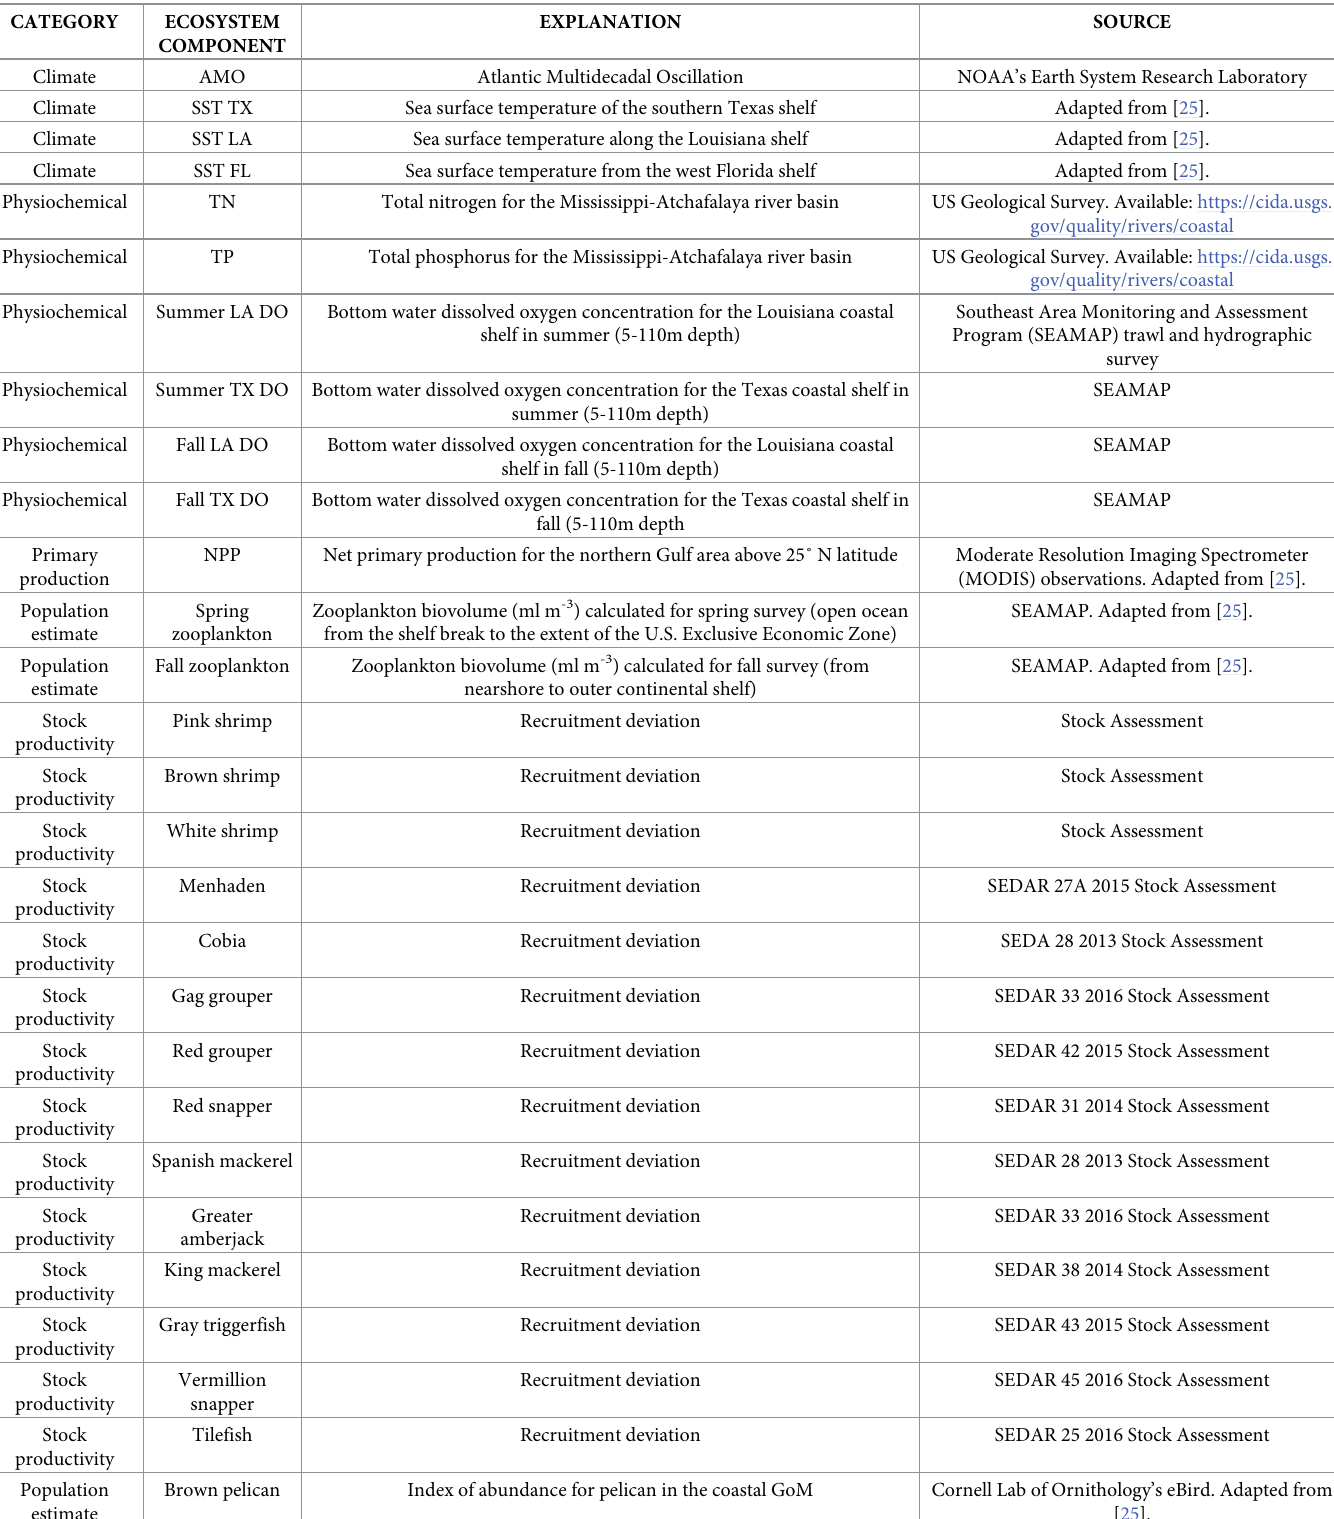
Table 1. Summary of